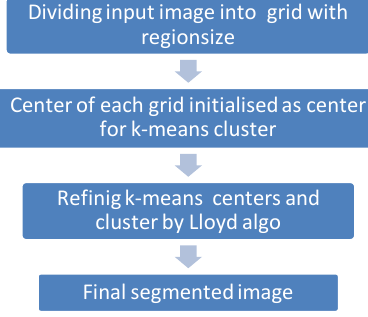
Figure 5. Working flow of SLIC algorithm